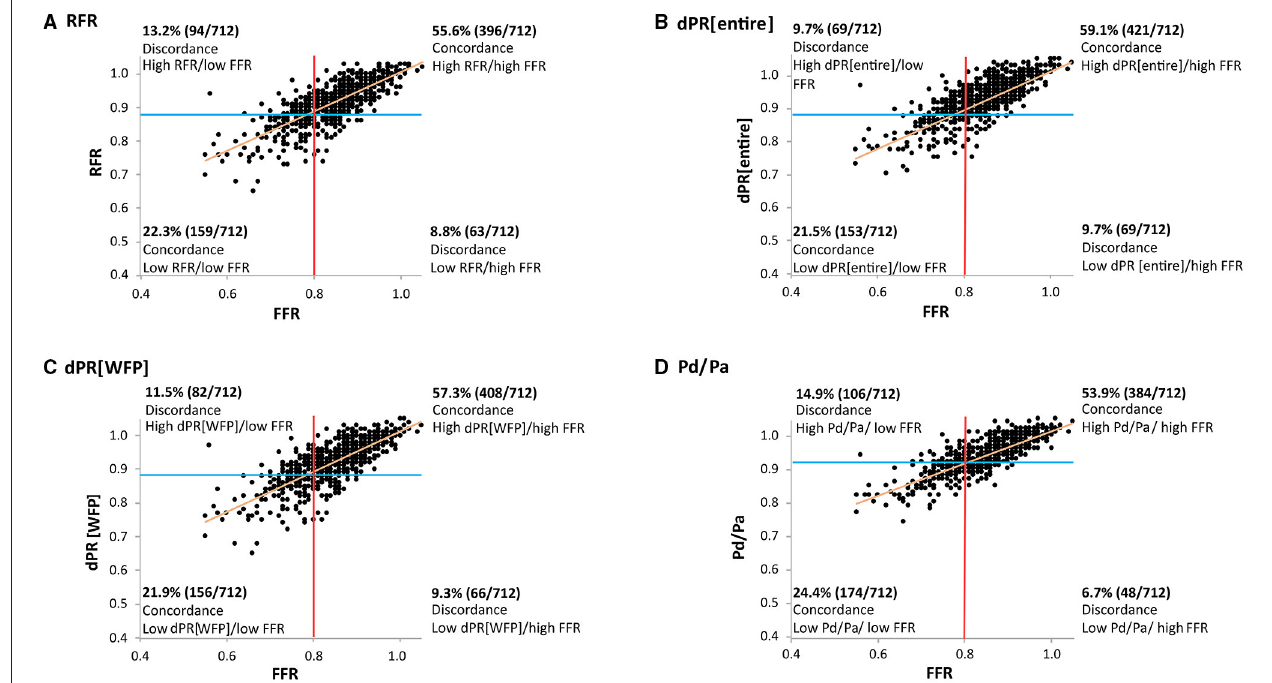
FIGURE 2 | Concordance and discordance among NHPRs and FFR. (A) FFR and RFR showed a significant correlation ( r = 0.766; p < 0.01), but 21.0% of lesions showed discordant classifications with FFR and RFR cutoff values of ≤ 0.80 and ≤ 0.89, respectively. (B–D) The correlation of FFR and dPR[entire], dPR[WFP] and Pd/Pa was also significant with a similar correlation coefficient. The frequency of discordant indices was comparable, too. dPR[entire], diastolic pressure ratio during entire diastole; dPR[WFP], diastolic pressure ratio during wave-free period; FFR, fractional flow reserve; NHPR, non-hyperemic pressure ratio; Pa, aortic pressure; Pd, distal coronary pressure; RFR, resting full-cycle